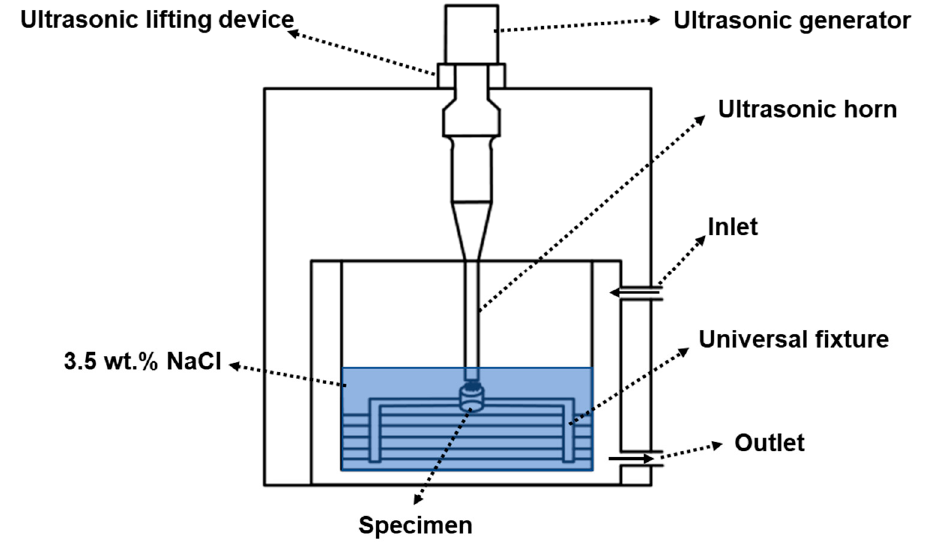
Figure 1. Schematic diagram of the CE equipment. Table 1. Chemical composition (wt.%) of the investigated NAB.